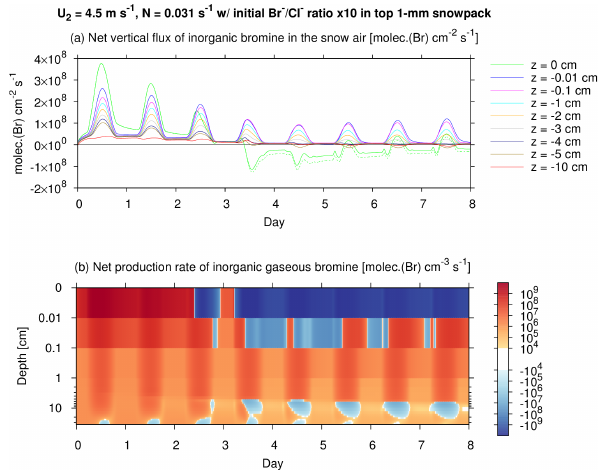
Fig. 9. The same as Fig. 8 but from a model run in which the initial concentration of Br − is increased by a factor of 10 in the top 1mm of the snowpack.